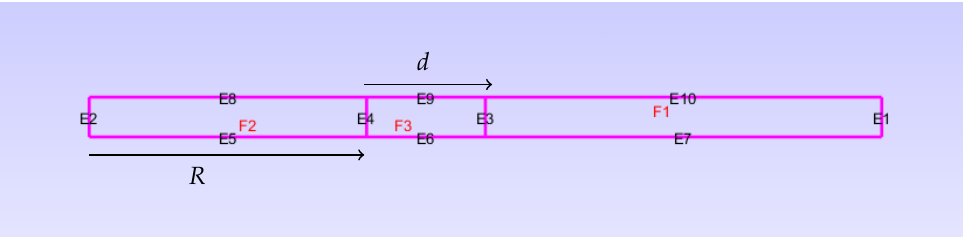
Figure 11. Edges’ and faces’